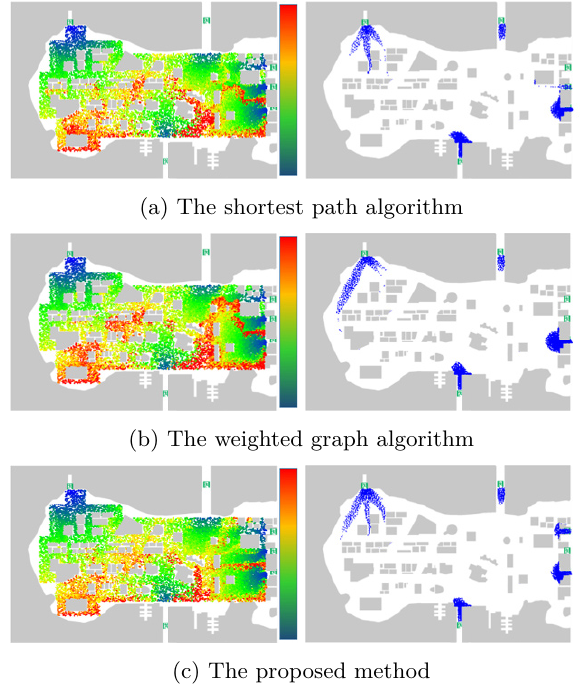
Fig. 12 Island modification: widths of the roads at the bottom and lower right exits were reduced by around one-half. Left: distribution of agent travel time. Right: the remaining agents at frame 4500.